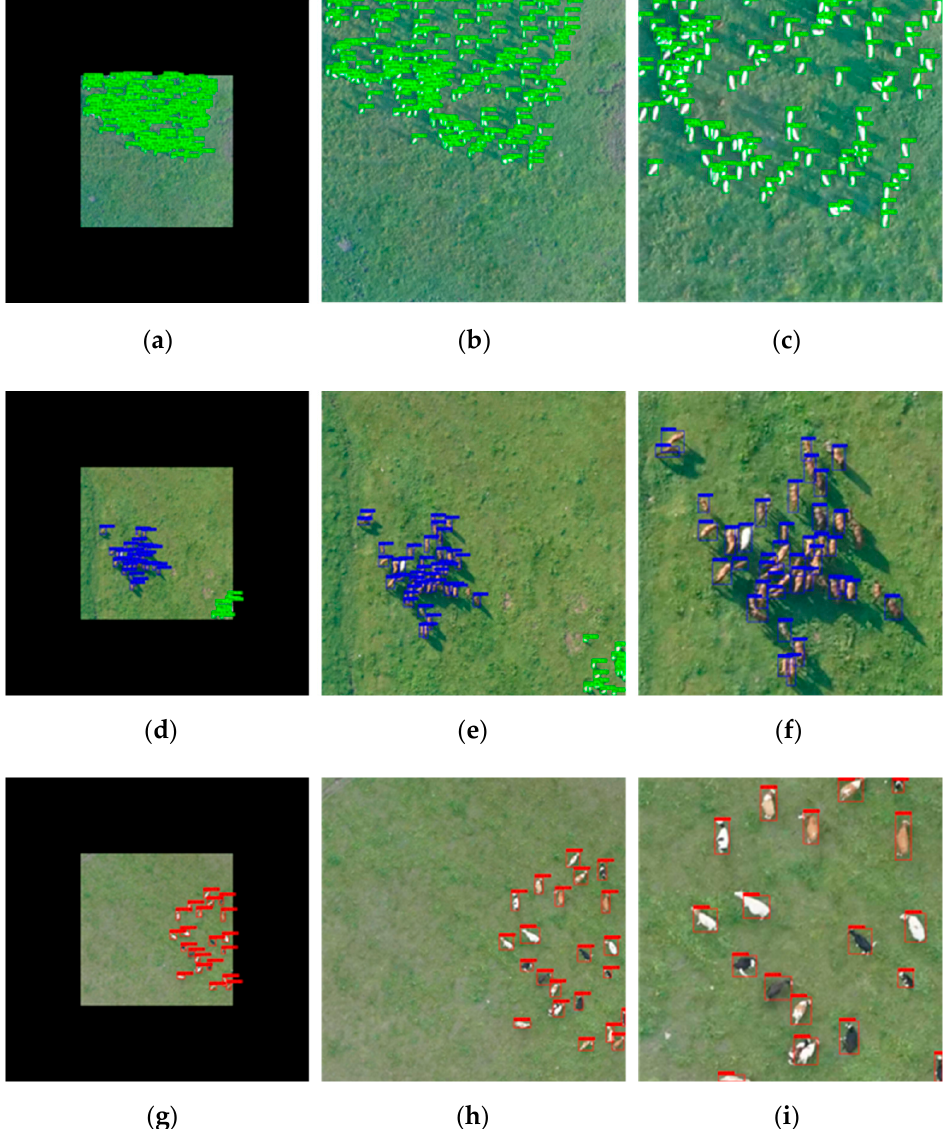
Figure 15. The detection results of the model at scales of 0.5, 1, and 2; ( a – c ) ca tt le at scales of 0.5, 1, and 2; ( d – f ) horses at scales of 0.5, 1, and 2; ( g – i ) sheep at scales of 0.5, 1, and 2.